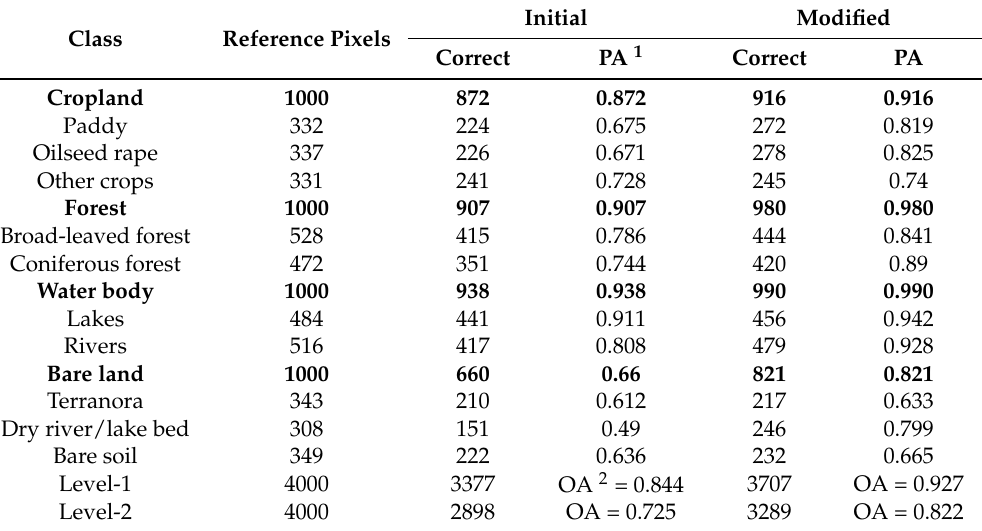
Table 4. Average classification accuracy of all seasons by both